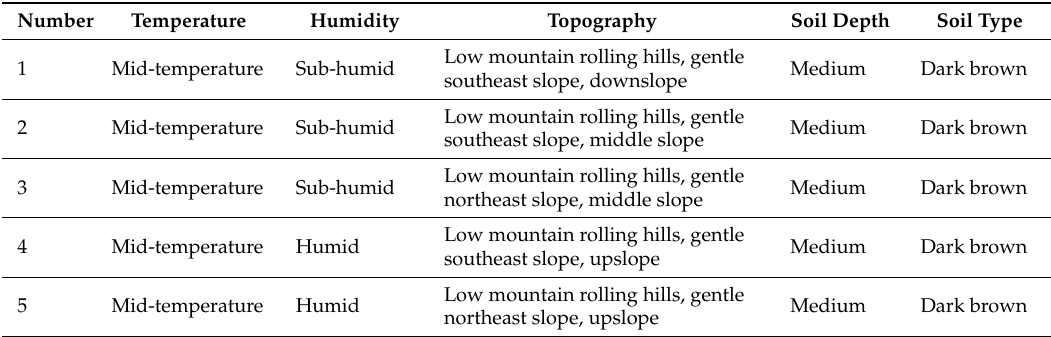
Table 1. Five main site types for permanent sample plots in Jilin